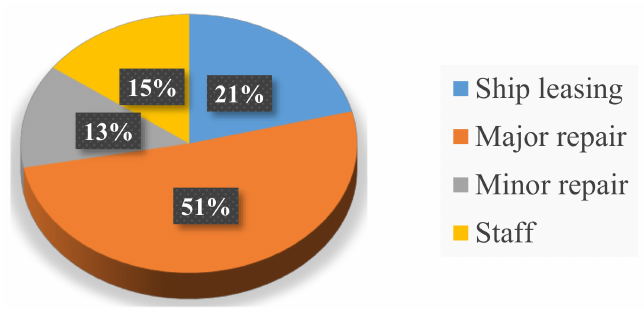
Figure 9. Proportion of maintenance cost for Dafengtian offshore wind farm.